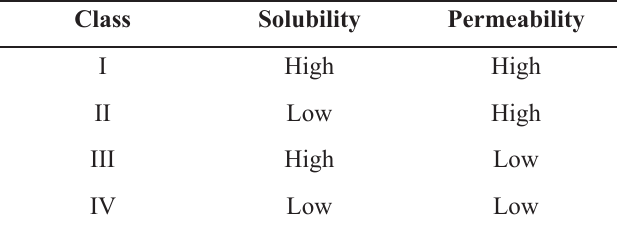
TABLE I -The Biopharmaceutical Classification System scientific framework